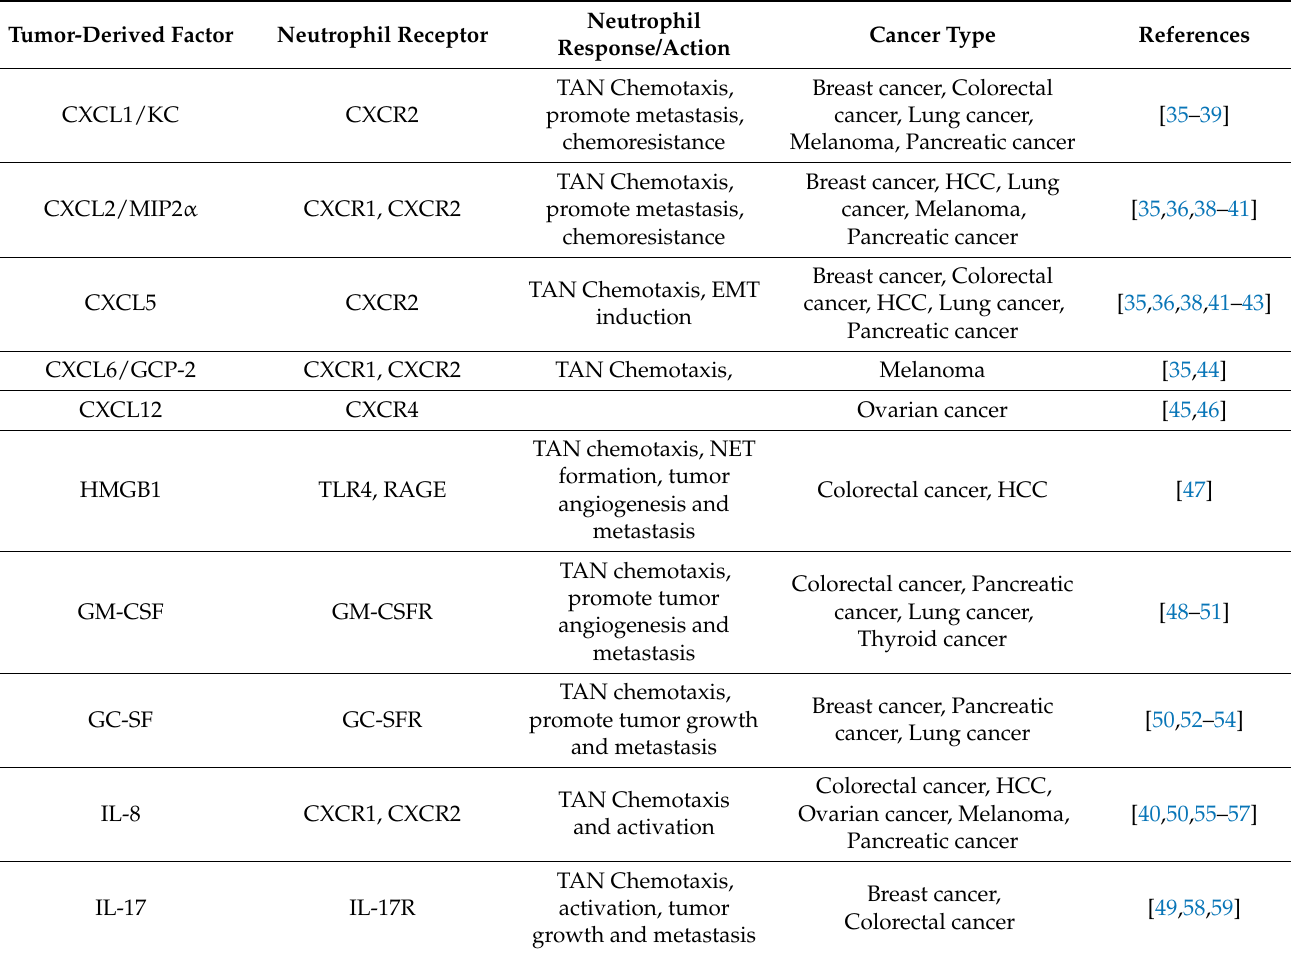
Table 1. Tumor-derived factors in recruiting neutrophils and stimulating Neutrophil Extracellular Traps (NETs) formation. Tumor-Derived Factor Neutrophil Receptor